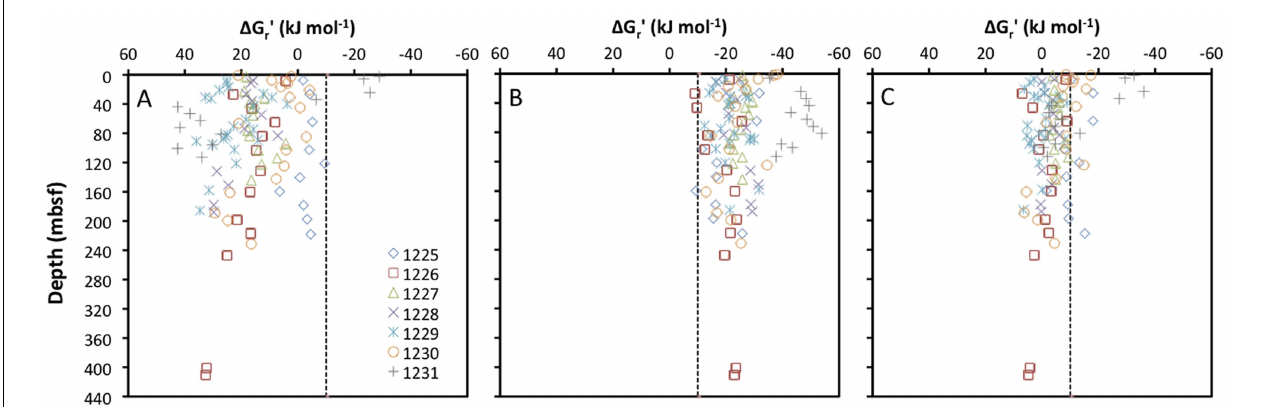
1225-31. All calculations are based on measurements from sediment cores collected during ODP Leg 201 (Shipboard Scientific Party,